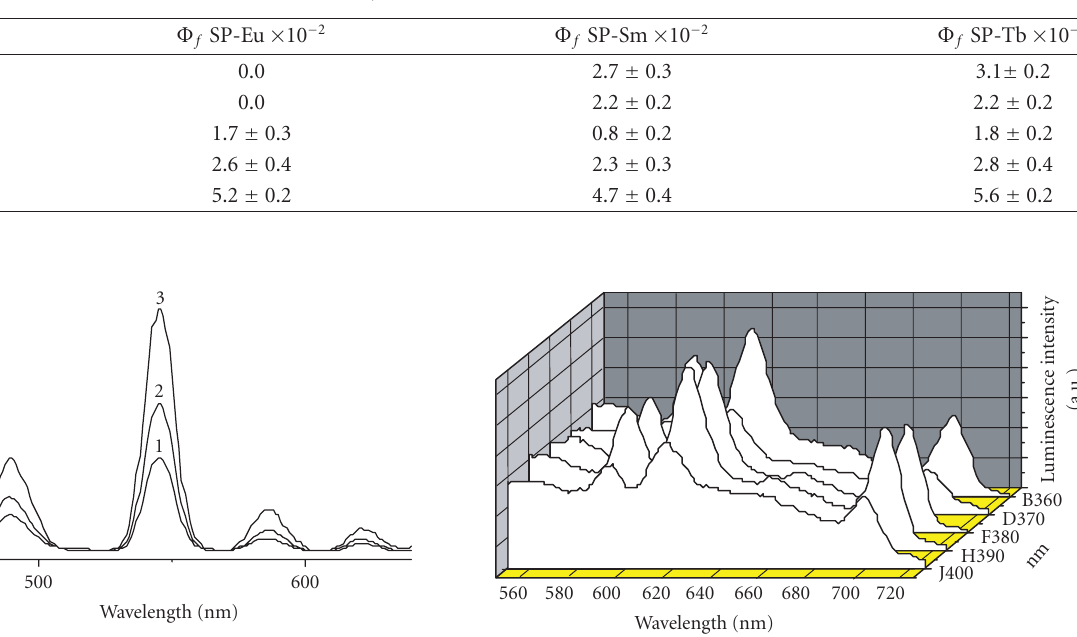
Table 5: Quantum yields values of (SP-M n+ ) at λ ex = 380nm.